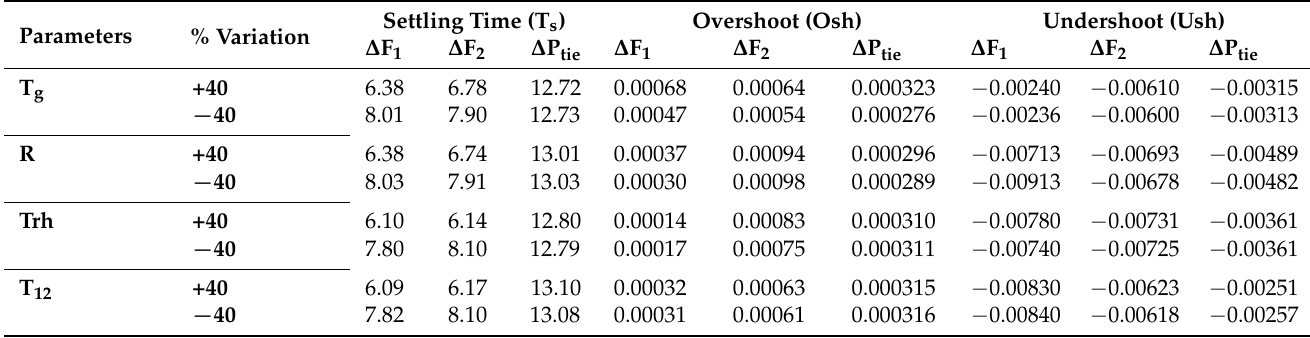
Table 4. Sensitivity analysis of the proposed controller for hybrid